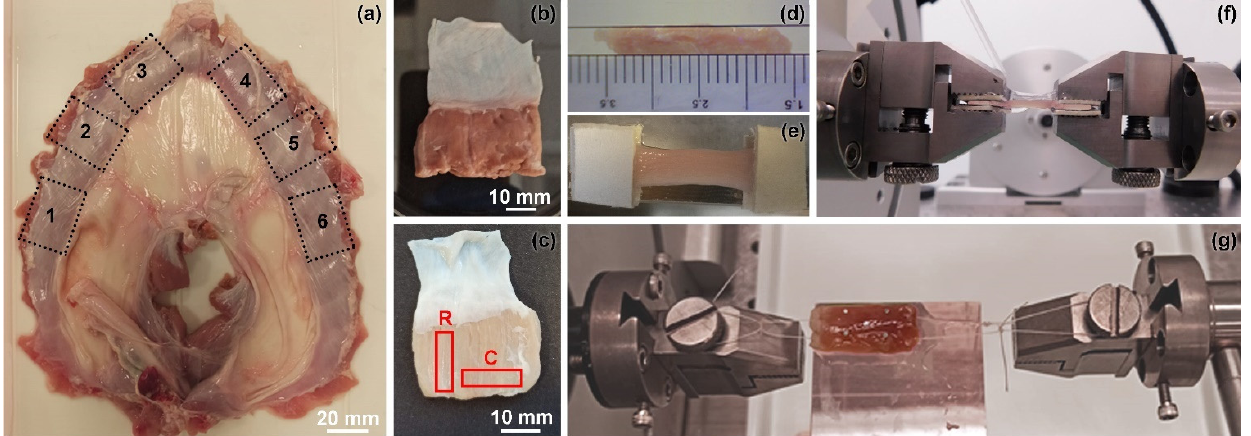
Figure 2. Entire porcine diaphragmatic muscles with resected patches highlighted with dotted lines ( a ); fresh ( b ) and decellularized ( c ) tissue patch with placement and orientation of radial (R) and circumferential (C) samples; lateral view of a decellularized tissue sample ( d ); top view of a decellularized tissue samples attached to balsa wood ( e ); gripping method with balsa wood ( f ); sample of muscular tissue attached with sutures ( g ).